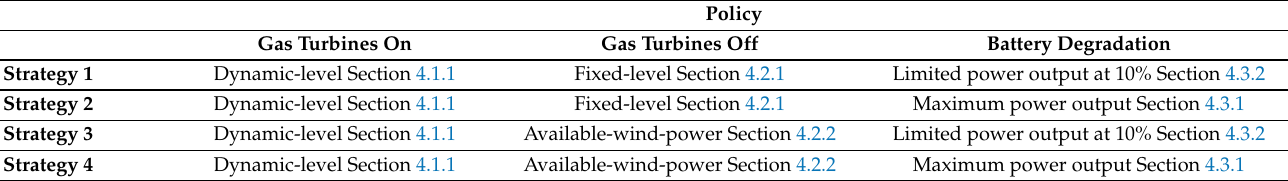
Table 1. Simulated control strategies and their associated policies.